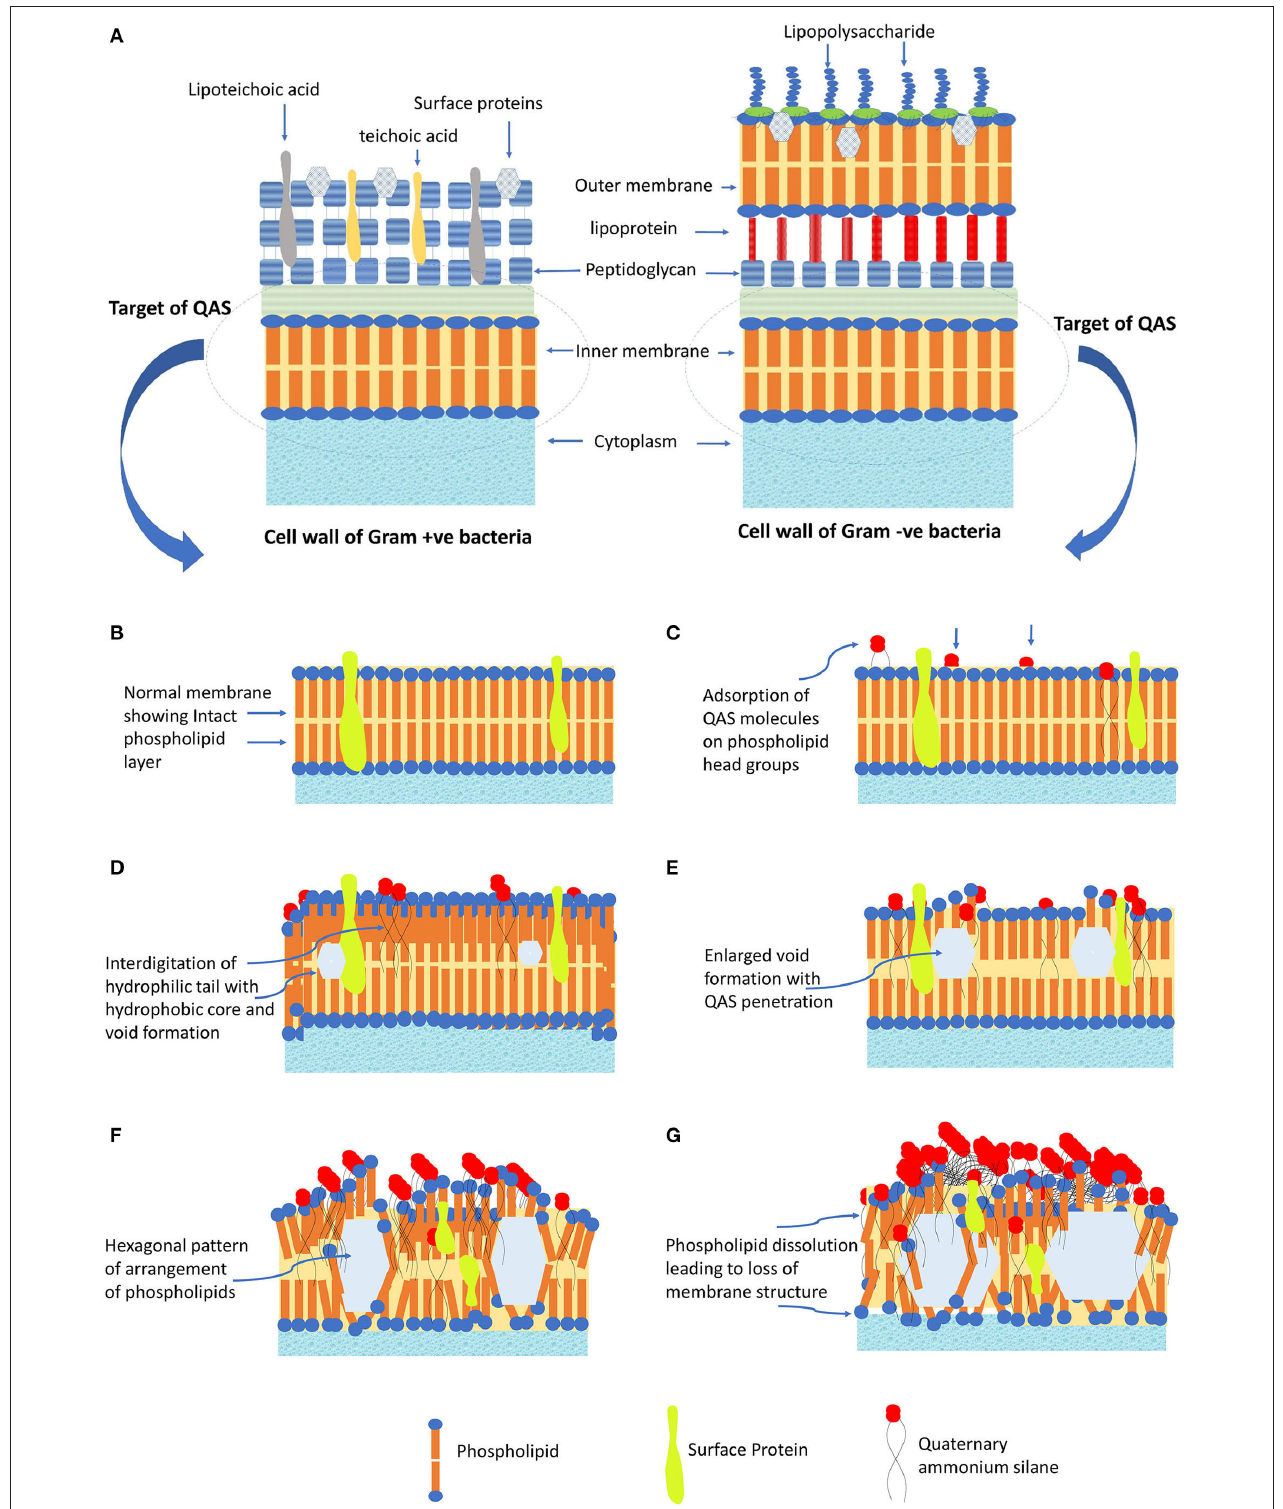
FIGURE 2 | The antibacterial mechanism of QAS. (A) Cell membrane structure of Gram + ve and Gram -ve bacteria. (B) Normal structure of cell membrane, showing structure arrangement of phospholipids and surface proteins. (C) QAS molecules adsorbed onto the head group of membrane phospholipids. (D) Hydrophilic tail interdigitate into the hydrophobic core of membrane leading to void formation. (E) Increased penetration leads to enlarged void formation, causing further weakening of membrane. (F) Change of membrane structure to fluid crystalline state with a hexagonal pattern of arrangement. (G) Protein perturbation ensues and dissolution of phospholipid leading to loss of cell membrane structure and cell